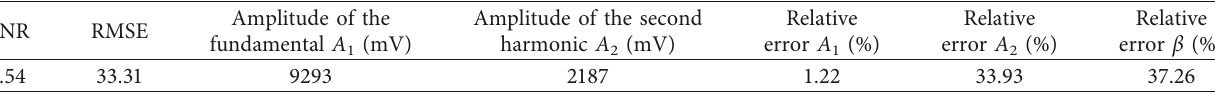
Figure 3: Time-frequency curve of the numerical signal after adding noise. Table 1: Characteristic indicators of the numerical signals after adding